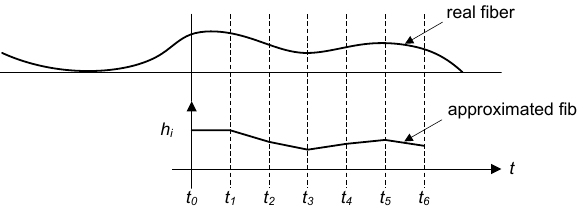
Figure 9. Approximation of the length of a fiber on the surface of a rolled product computed by a triangulation-based flatness